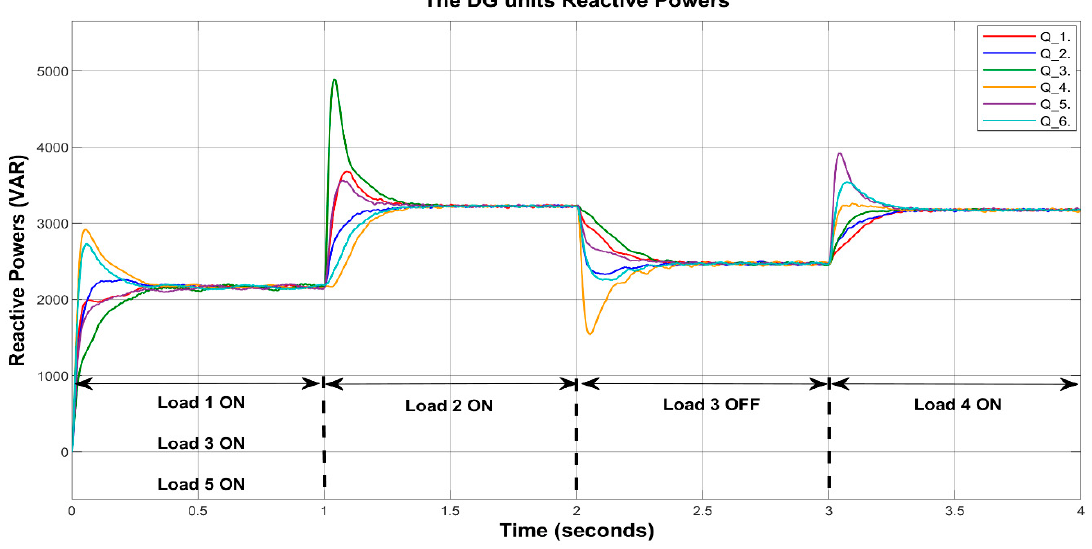
Figure 19. The DG units’ reactive powers for Case 4. 4.1.5. Case 5: Leaderless Consensus Control with Triangle Mesh Communication Topology Based on previous cases, there is an inverse relationship between the rate of convergence and the cost of the communication topology. In this case, a triangle mesh communication topology with leaderless consensus control algorithm is proposed in order to find a topology that balances the rate of convergence to consensus and the overall system cost. Figure 5 illustrates the triangle mesh